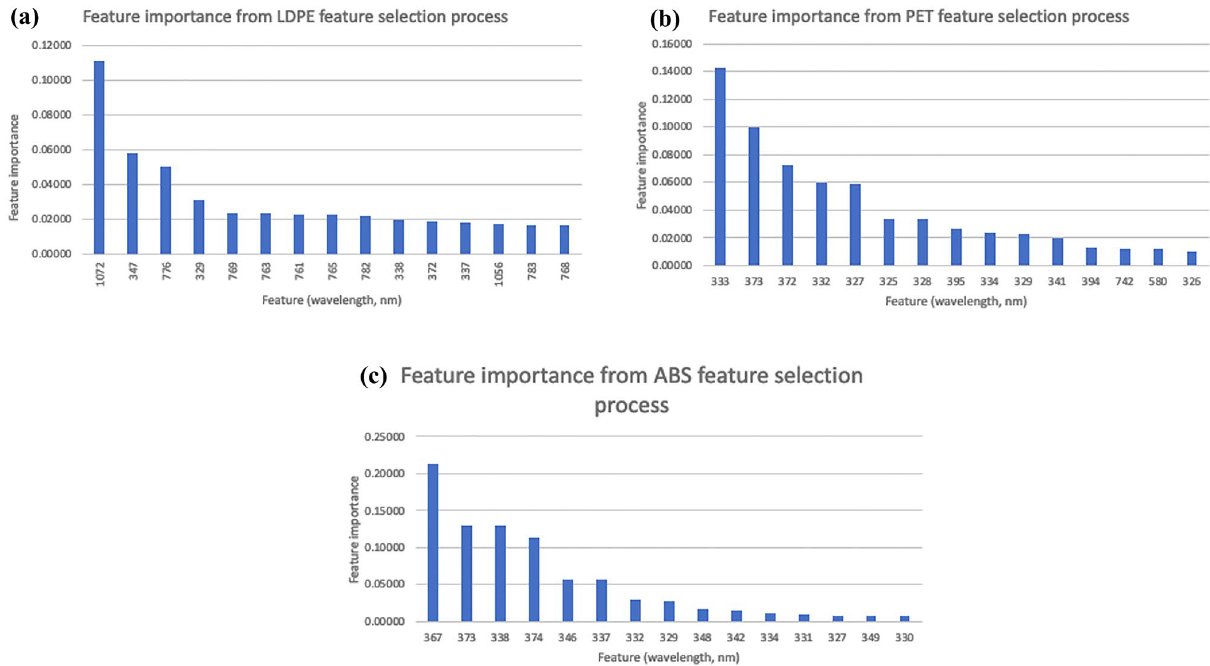
Figure 3. Feature importance of top 15 features from ( a ) LDPE, ( b ) PET and ( c ) ABS data (obtained from feature selection and RF regressor functions in Scikit-Learn). These feature importance graphs rank the wavelengths based on importance in the model development. The highest ranked wavelengths for LDPE, PET and ABS are 1072 nm, 333 nm and 367 nm, respectively. The reflectance values at these wavelength points are applied during the regression models